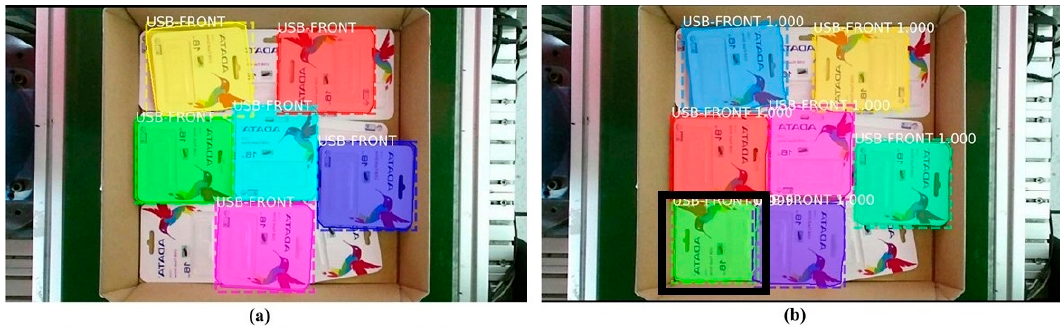
Figure 20. Confusion matrix of the classification results from the model.